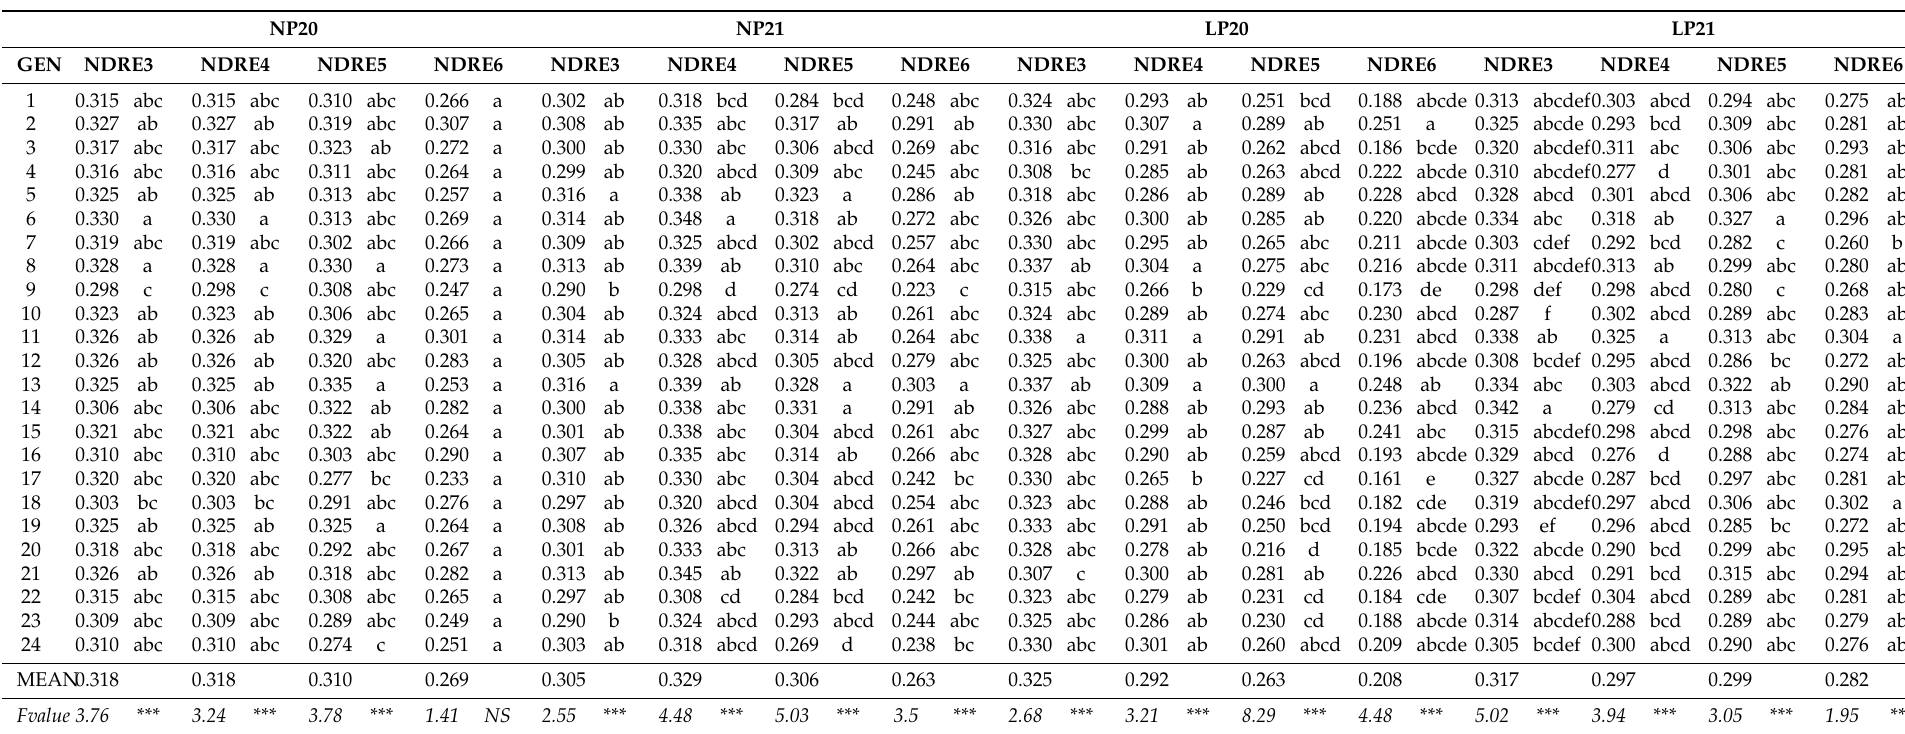
Table 5. Average NDRE index value by genotype at four monitoring dates. The specific monitoring covers the period from the middle of the reproductive stage till the beginning of the ripening stage. Means and ANOVA F values to verify the occurrence of genetic variation among lines for each